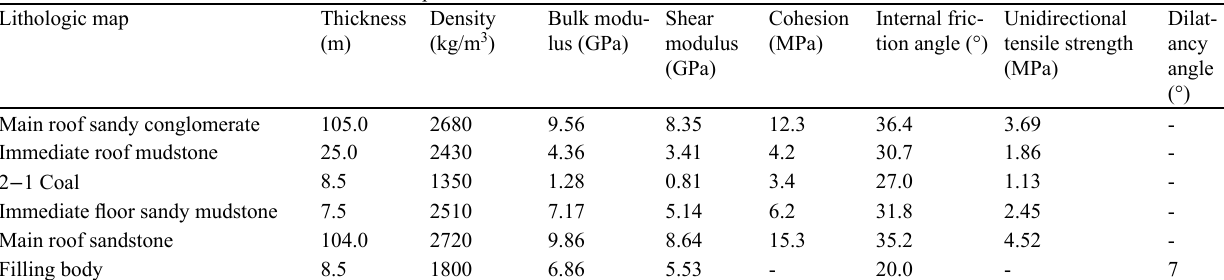
Table 2 Numerical simulation of rock mechanics parameters Lithologic